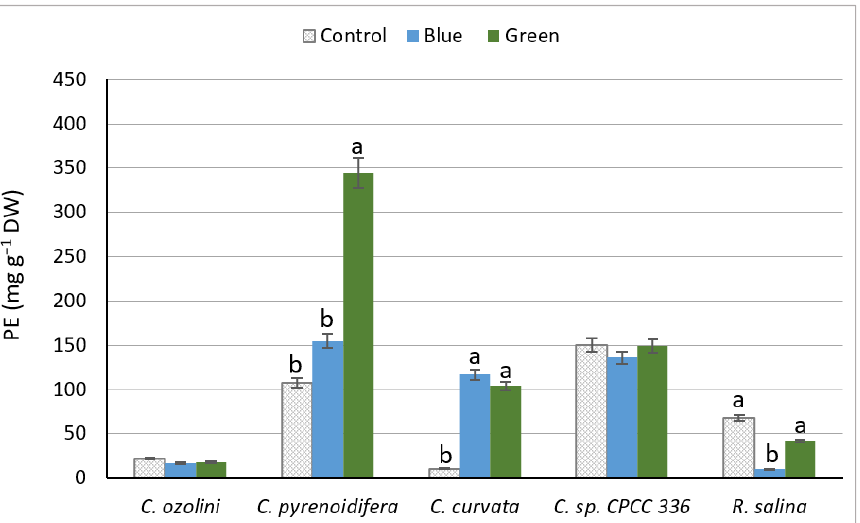
Figure 2. Phycoerythrin (PE) concentration (mg PE g − 1 dry weight) extracted from five different cryptophyte species cultivated under various light lights (control (white), blue, and green lights with different intensities). Significant differences between samples are indicated with different letters as determined by ANOVA comparison ( p <